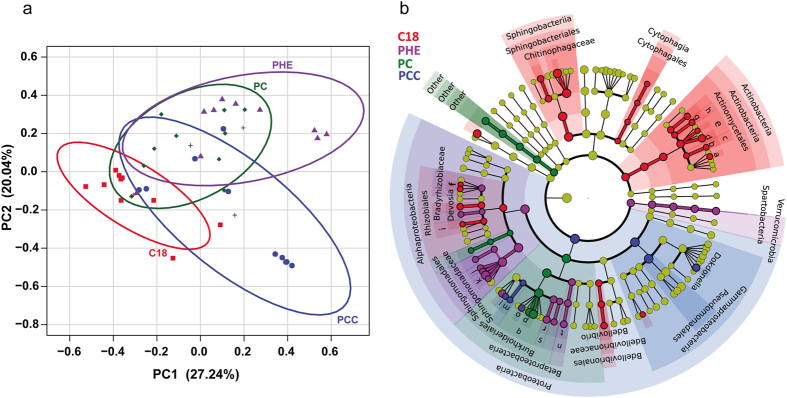
Distinct microbial patterns of the different treatments.(a) Weighted UniFrac distance principal coordinate analysis (PCoA) of microbial communities among the forty consortia in the four treatments. 80% confidence ellipses are shown around each treatment group. (b) LDA effect size taxonomic cladogram comparing all consortia categorized according to treatments. Significantly discriminant taxon nodes are colored, and branch areas are shaded according to the highest-ranked variety for that taxon. The yellow nodes correspond to taxa that were not significantly differentially represented between treatment groups. Highly abundant and selected taxa are indicated: a, Microbarterium; b, Nakamurella; c, Nakamurellaceae; d, Gordonia; e, Nodcardiaceae; f, Nitrobacter; g, Aeromicrobium; h, Nocardiodidaceae; i, Phyllobacteriaceae; j, Novosphingobium; k, Sphingobium; l, Pigmentiphaga; m, Aquabacterium; n, Nitrosomonadaceae; o, Delftia; p, Hydrogenophaga; q, Comamonadaceae; r, Naxibacter; s, Oxalobaceraceae; t, Nitrosomonas. For the complete list of discriminate taxa and ranks used to generate this cladogram, see Dataset S1.